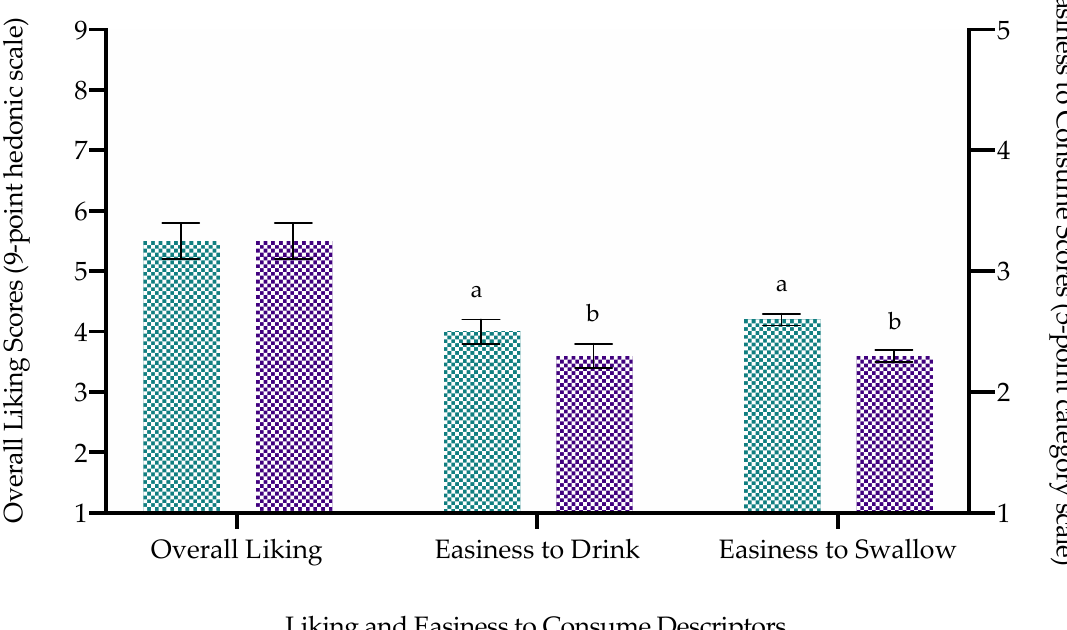
Sample significant differences denoted by differing small letters.